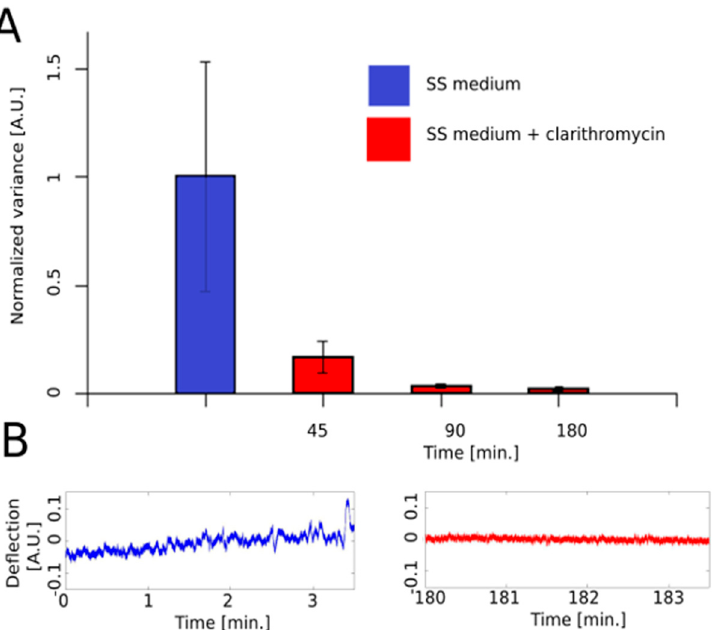
Figure 4. Illustration of the effect of clarithromycin on B. pertussis nanomotion. ( A ). Effect of the antibiotic at MIC on the variance of the nanomotion signal as a function of time before (blue column) and after (red columns) the exposure of the microorganism to the antibiotic. ( B ). Oscillations of the cantilever as a function of time before (blue curve) and after (red curve) the injection of the drug. SS medium: Stainer–Sholte liquid medium. The details of the preparation procedure are described in Appendix A.